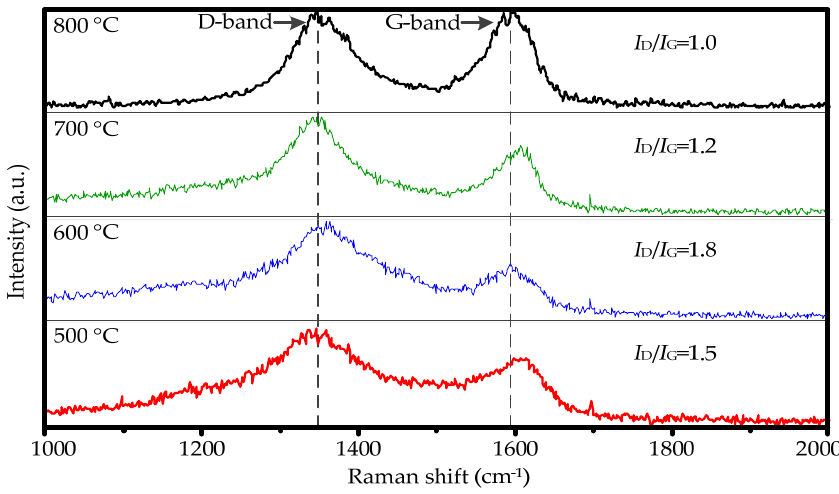
Figure 4. Raman spectra of the samples obtained at 500, 600, 700, and 800 °C on the substrate.